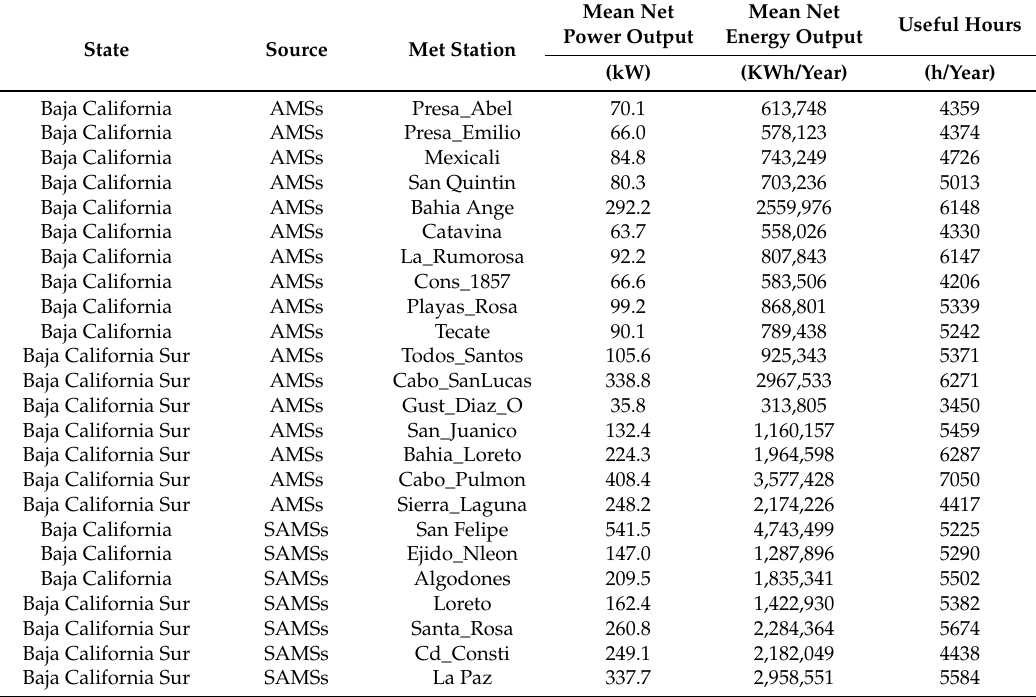
Table 4. Mean Net Power and Energy